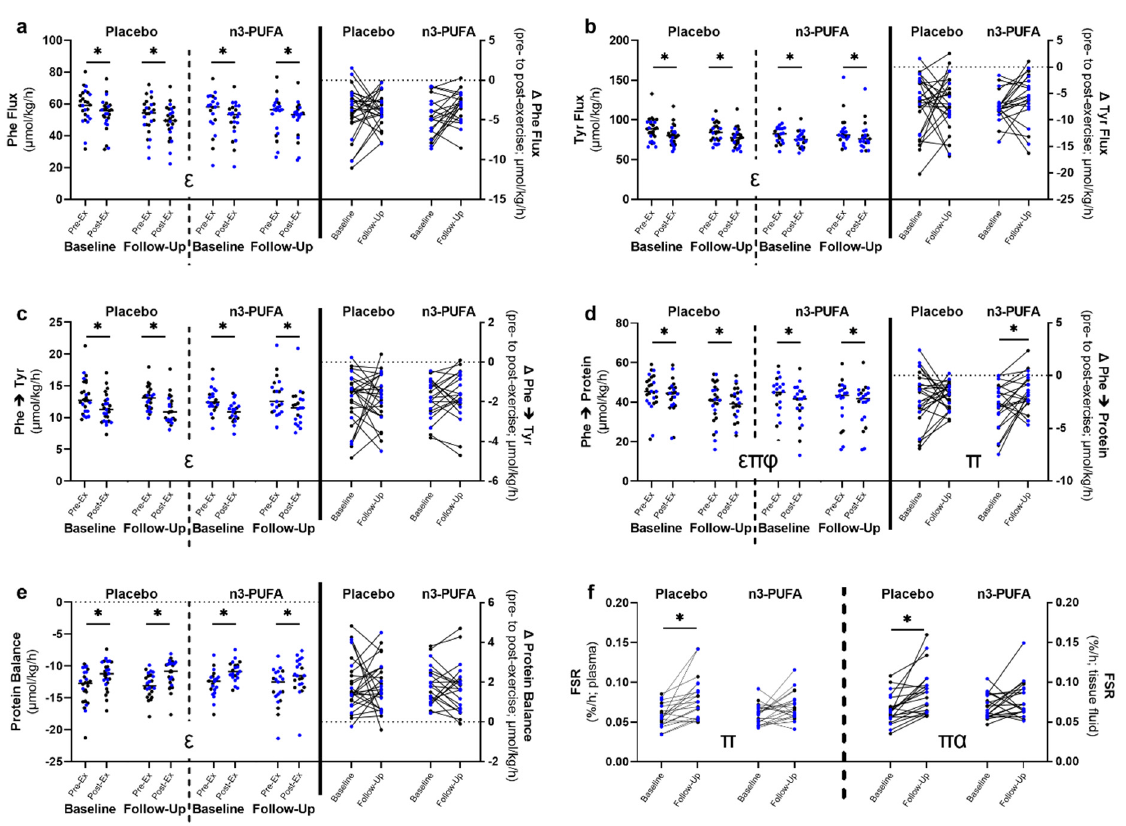
Figure 4. The effects of 6-months of placebo or n3-PUFA on whole-body amino acid kinetic and skeletal muscle fractional synthesis rate responses to acute exercise. ( a – e ) Whole-body amino acid kinetics were measured pre- and post-acute exercise (pre-ex; post-ex, respectively) in older (65–85 years) adults before (baseline) and after (follow-up) 6-months of placebo or n3-PUFA supplementa- tion administered in randomized, double-blind fashion. Kinetics were determined using the triple tracer approach and assessed ( a ) phenylalanine (Phe) flux; ( b ) tyrosine (Tyr) flux; ( c ) the conversion of phenylalanine to tyrosine (Phe → Tyr); ( d ) the conversion of phenylalanine to protein (Phe → protein); and ( e ) the balance between protein synthesis and protein breakdown (placebo: n = 26; n3-PUFA: n = 21). Steady state was achieved before and after an acute bout of resistance exercise, and the absolute change in kinetics from pre- to post-exercise ( ∆ ) was calculated ( a - e ). ( f ) Mixed skeletal muscle protein fractional synthesis rates associated with acute exercise were measured before and after 6 months of placebo or n3-PUFA supplementation. Acute exercise-associated mixed muscle protein fractional synthesis rates were calculated from the isotopic enrichment of labeled amino acid tracers measured in serial muscle biopsies collected before and after acute exercise (placebo: n = 20; n3-PUFA: n = 20). Plasma and tissue fluid isotopic enrichments were used as precursor pools to determine the low and high limits of the true FSR. For the whole-body amino acid kinetics, mixed repeated measures ANOVAs were performed to determine the within-subjects effects of time (base- line, follow-up) and exercise (pre-ex, post-ex), the between-subjects effects of the intervention (n3- PUFA, placebo) and the interactions between time, exercise, and intervention. For the Δ and FSR values, mixed repeated measures ANOVAs were performed to determine the within-subjects effects of time (baseline, follow-up), the between-subjects effects of the intervention (n3-PUFA, placebo) and the interaction between time and intervention. Significance was set a priori at p < 0.05. Post hoc pairwise comparisons were performed when significant main or interaction effects were identified. Individual data points represent individual participants, with blue data points representing males and black data points representing females. Bars indicate mean and standard deviation. ε represents a significant main effect of exercise; π represents a significant main effect of time; φ represents a significant exercise-by-time interaction; α represents a significant time-by-intervention interaction; * represents a significant within-group difference based on post hoc pairwise comparisons. Phe: phenylalanine; Tyr: tyrosine; FSR: fractional synthesis rate.